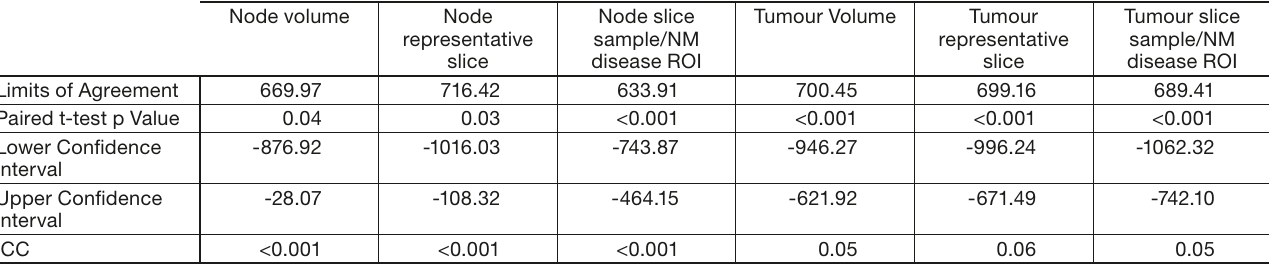
Conclusion: Even in the presence of significant post-treatment change, ADC values at existing or previous sites of H&N cancer can